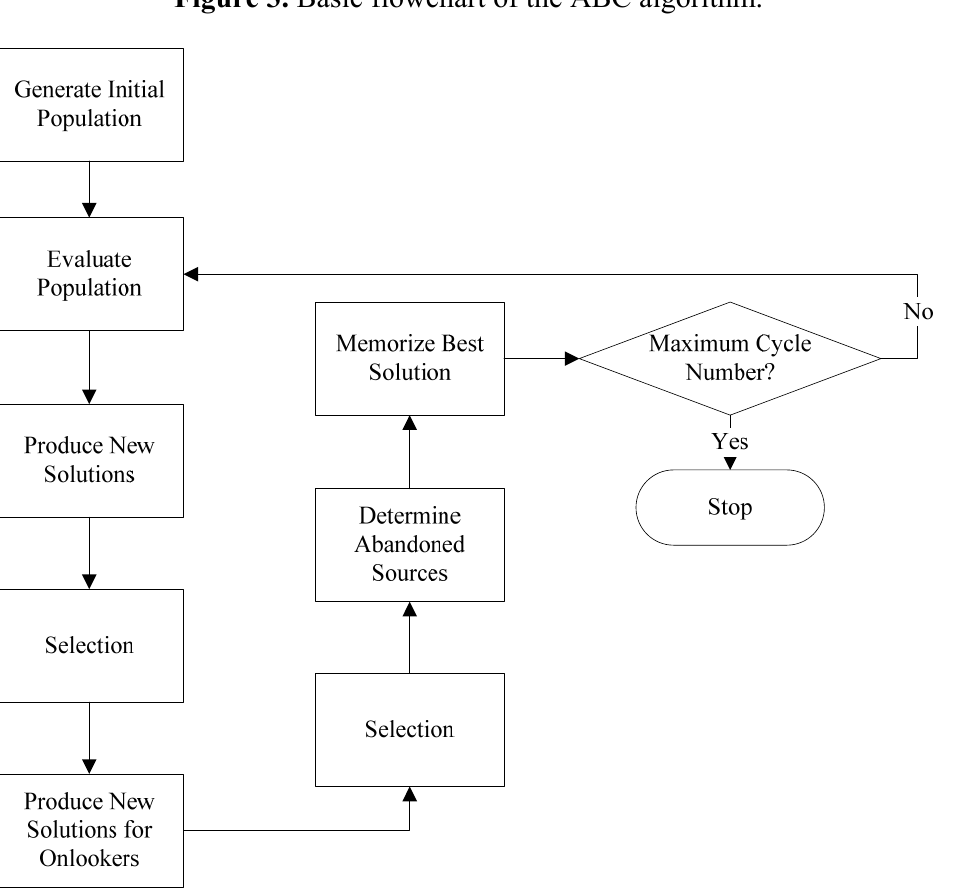
Figure 3. Basic flowchart of the ABC